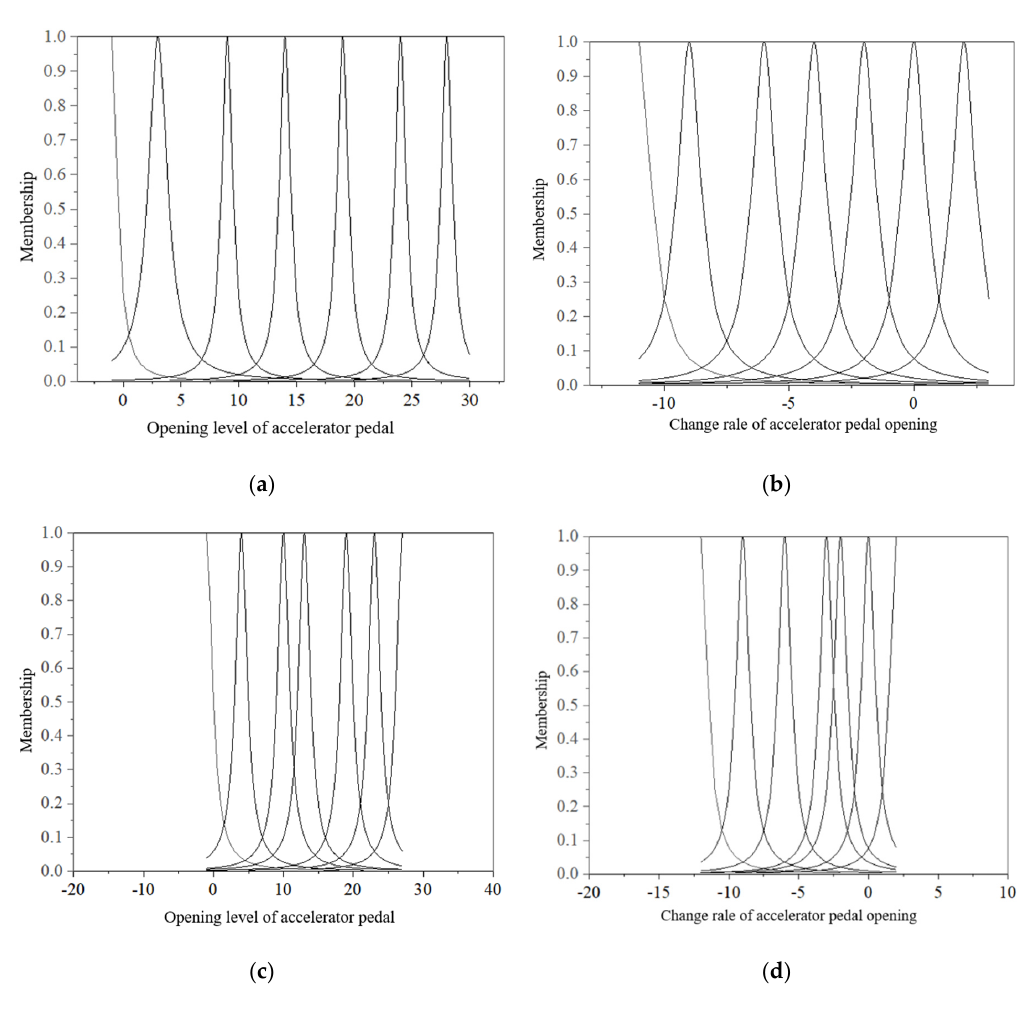
Figure 12. Electric tractor pedal opening and pedal opening change rate affiliation function graph. ( a ) Plot of pedal opening affiliation function before training; ( b ) plot of the affiliation function of the pedal rate of change before training; ( c ) plot of pedal opening affiliation function after training; ( d ) plot of the affiliation function of the pedal rate of change after training.